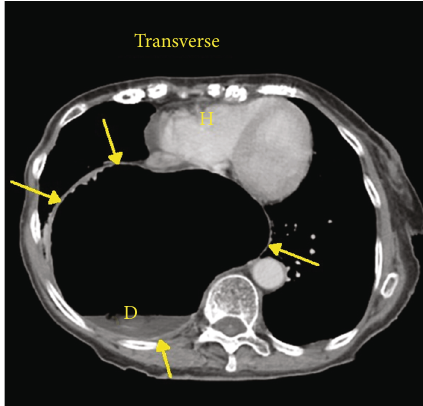
Figure 2: Transverse chest CT of the abdomen showing large hiatal hernia with concern for gastric volvulus or gastric outlet obstruction. The large hernia is between the yellow arrows. The heart is “ H, ” and the debris in the bowel is “ D. ”